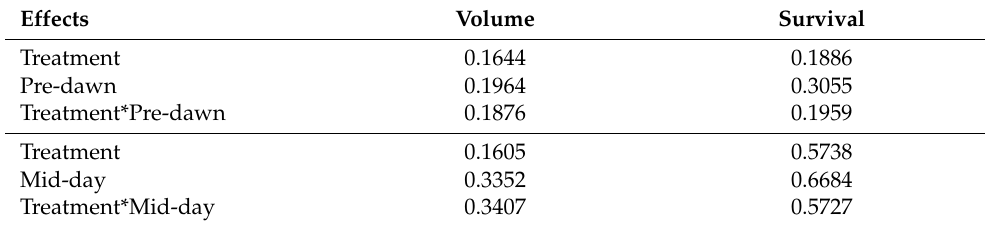
Table 6. ANCOVA p -values between pre-dawn and mid-day water potential and volume and survival.